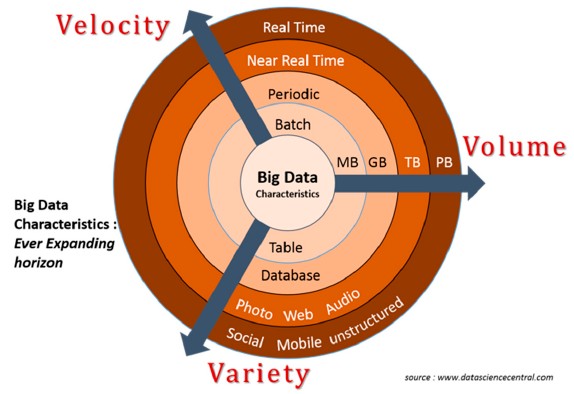
Figure 2. 3V of big data (source: www.datasciencecentral.com).